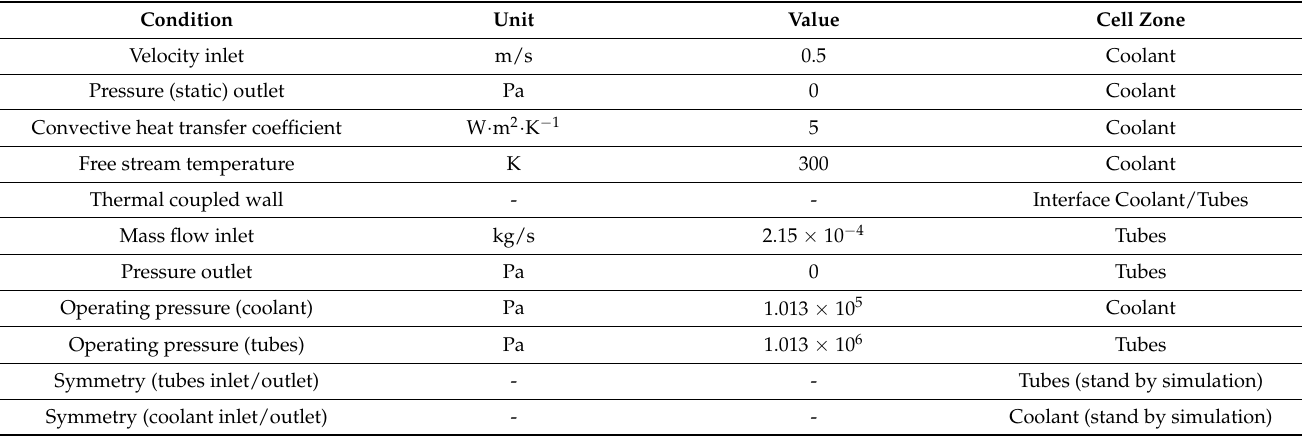
Table 4. Boundary and cell zone conditions.